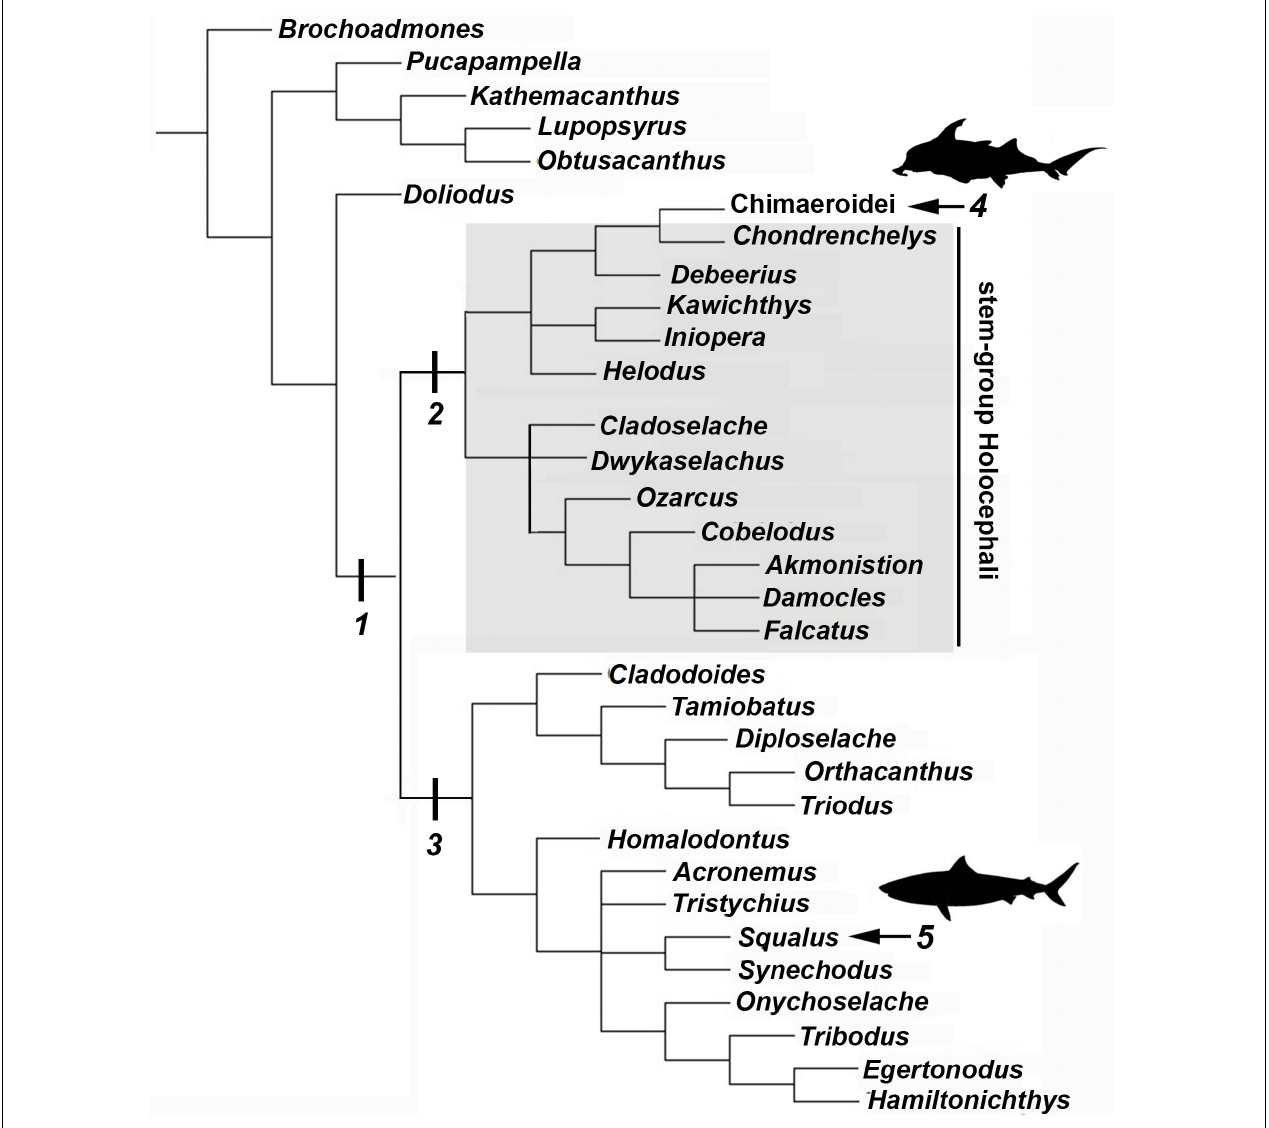
FIGURE 8 | Chondricthyan phylogeny (after Coates et al., 2018). 1, Crown–group Chondrichthyes (Holocephali + Elasmobranchii); 2, Holocephali; 3, Elasmobranchii; 4, Crown–group Holocephali; 5, Crown–group